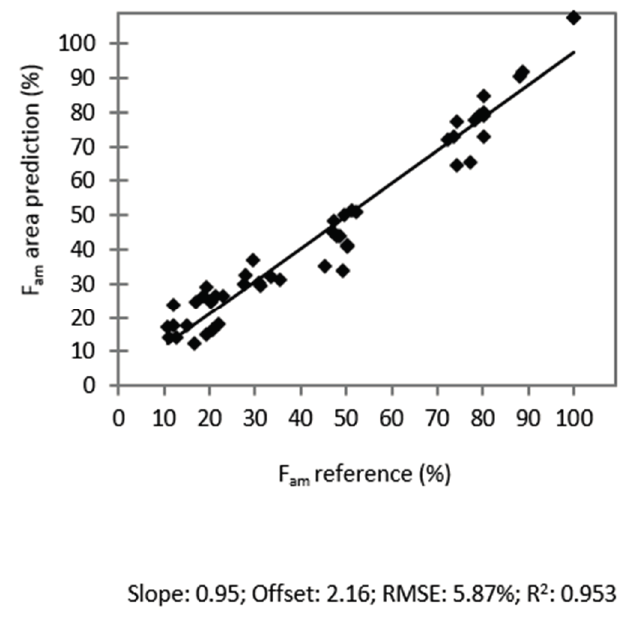
Figure 7. Correlation of the predicted amorphous fractions based on the relative area under the Bragg peaks vs. the reference